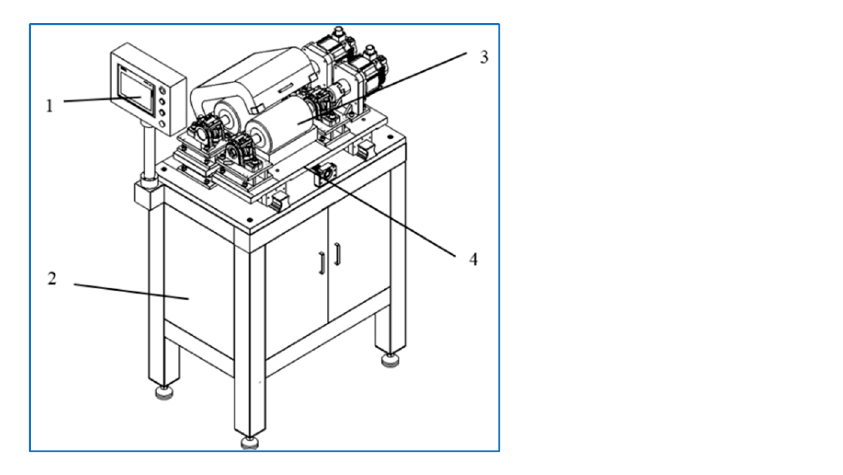
Figure 1. Model of roll coating simulation test equipment. (1—HMI, 2—Power distribution cabinet, 3—Roll coating rotor components, 4—Mobile